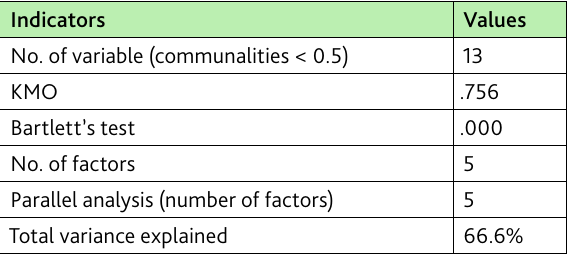
Table 7. PCA indicators for Serbia